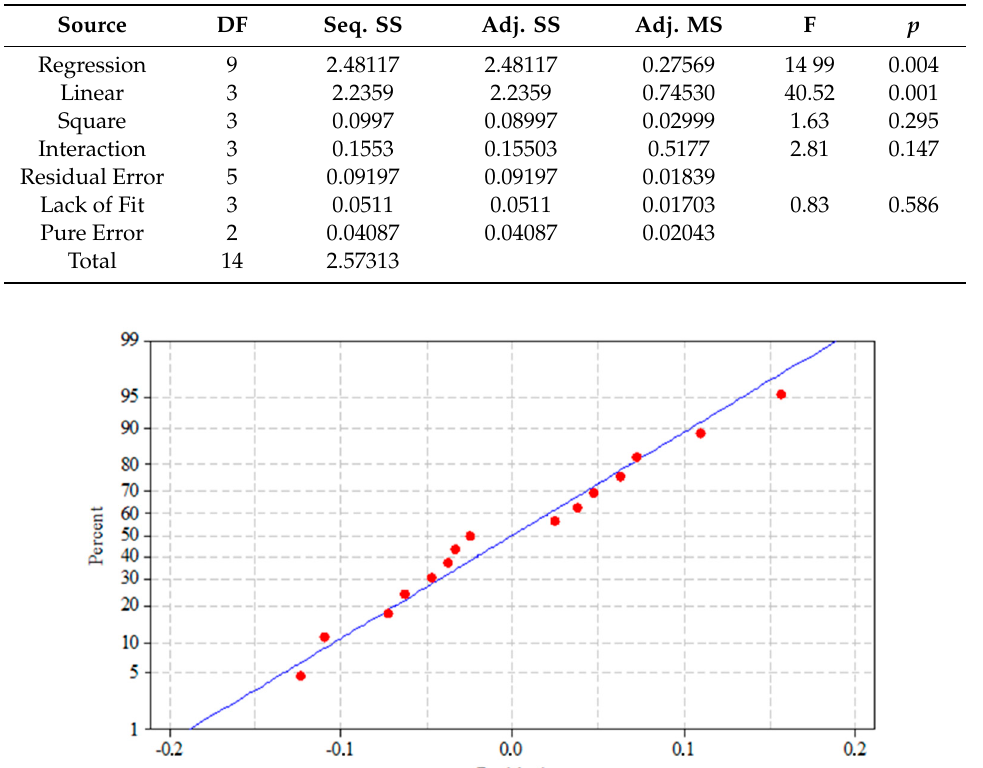
Table 10. ANOVA test results of response surface model for Ra.